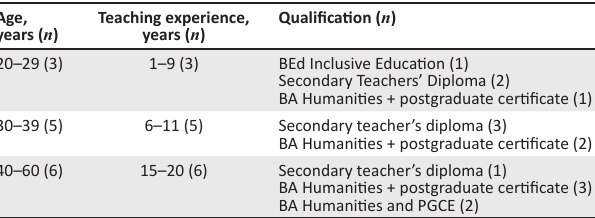
TABLE 2: Summary of teacher